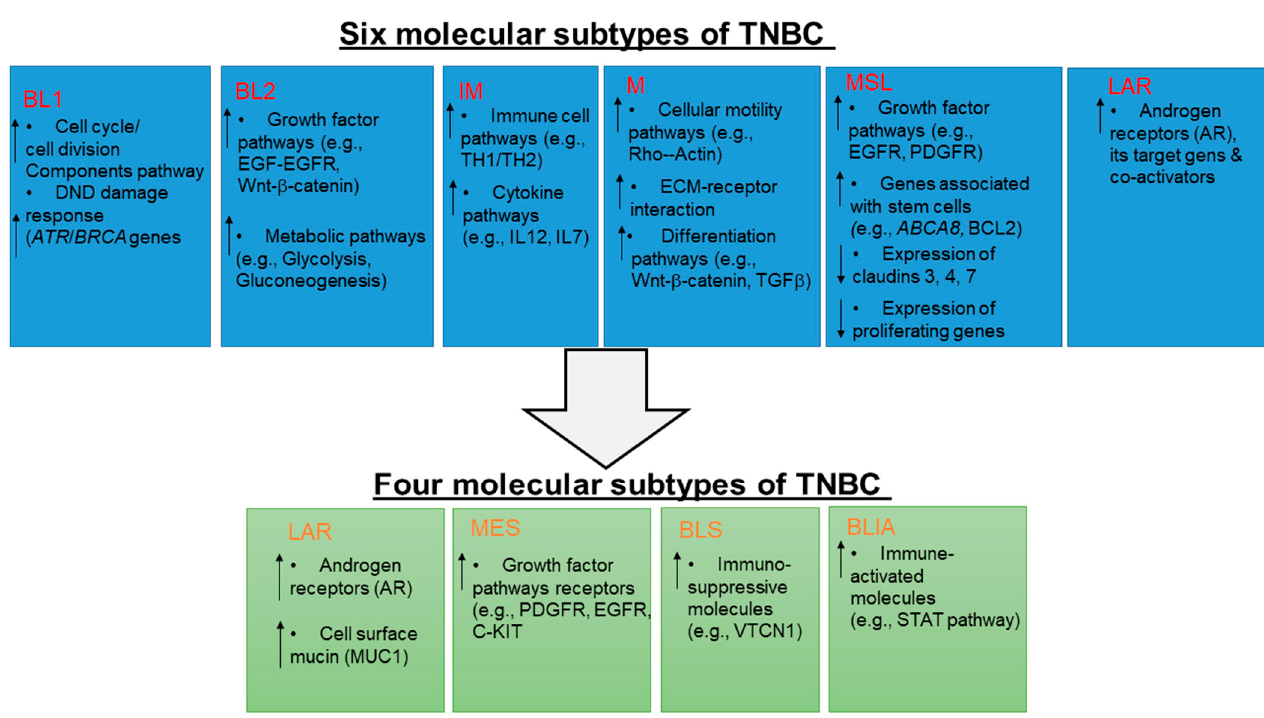
Figure 1. Schematic illustration of the molecular subtypes of triple-negative breast cancers. The blue and green boxes are six subtypes and four different subtypes of triple-negative breast cancer (TNBC), respectively, with their characteristic features. The six subtypes are BL1 , basal-like 1; BL2 , basal-like 2; IM , immunomodulatory; M , mesenchymal; MSL , mesenchymal stem-like; LAR , luminal androgen receptor. Four subtypes are LAR , luminal AR; MES , mesenchymal enrich; BLIS , basal-like immunosuppressive; BLIA , basal-like immune activated.